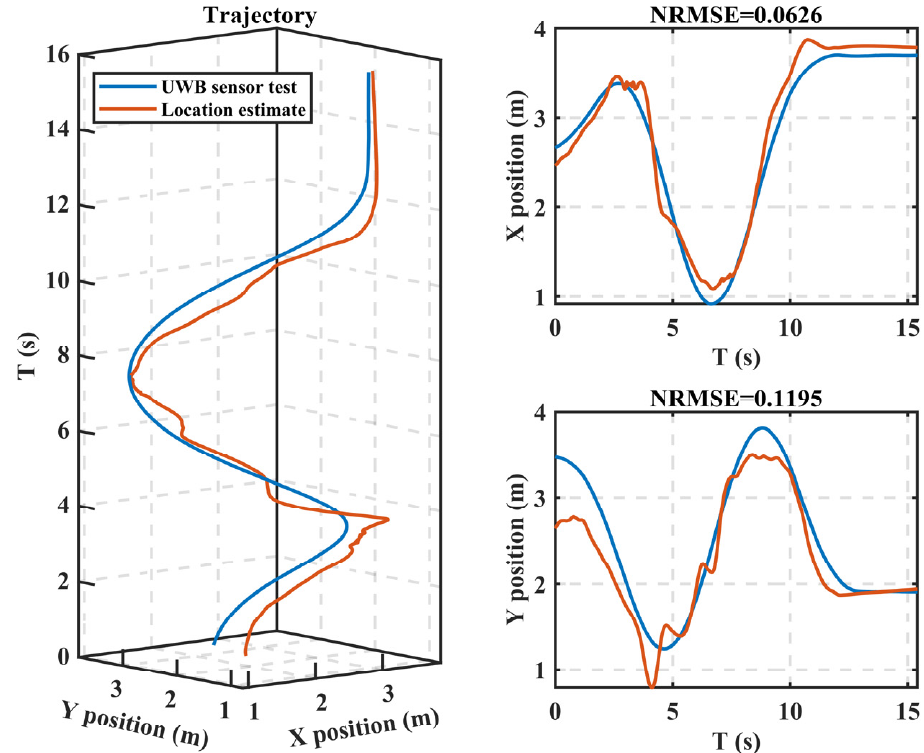
Figure 11. Typical results of the location inversion based on electrostatic potential signals. The left picture gives the motion trajectory, the upper-right figure gives the X -coordinate, and the bottom figure gives the Y -coordinate.